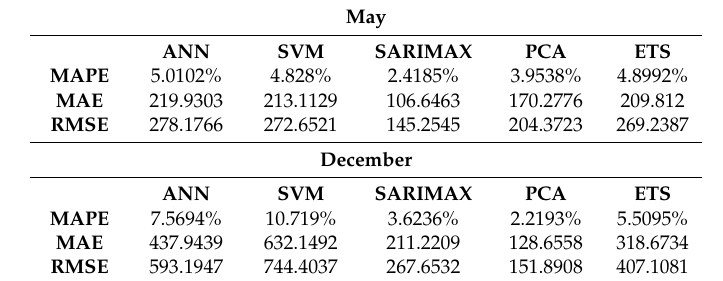
Figure 23. General structure of the ANN we apply. Figure 25. SVR forecast for May 2014.